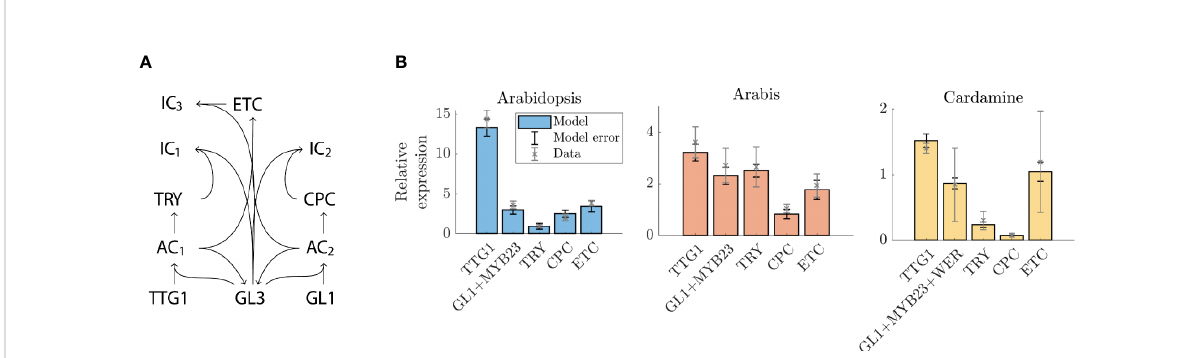
FIGURE 3 Expression levels in the model compared to qPCR data. (A) Schematic representation of model network. AC1 and AC2 are the active complexes TTG1 GL3 and GL1 GL3; IC1 and IC2 are the inactive complexes TRY GL3 and CPC GL3. (B) Expression levels of genes in A . thaliana, A. alpina , and C . hirsuta relative to GL3+EGL3. The qPCR data is indicated by grey crosses with error bars (representing biological replicates) and the model expression levels are indicated by the bars (blue for A . thaliana , red for A . alpina , yellow for C . hirsuta ), the model error (black error bars) is the error over the 10 best fi tting parameter